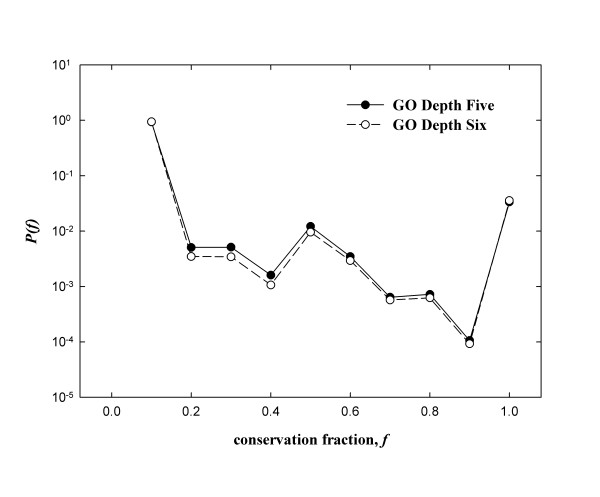
Distribution of the conservation fraction of motif modes in the yeast PPI network. Distribution of the conservation fraction of motif modes shown on a semi-log plot are marked as filled and open circles when the GO terms at depths five and six were employed, respectively.